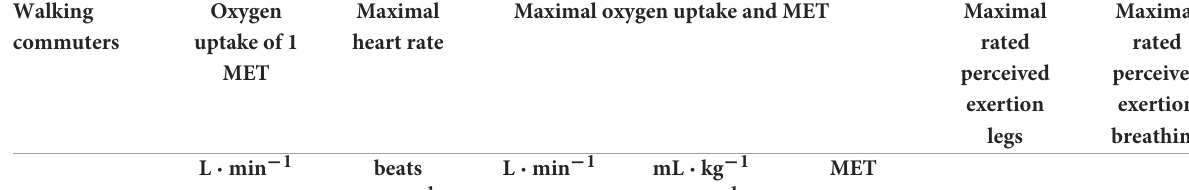
TABLE 3 Maximal values of heart rate, oxygen uptake, MET and rated perceived exertion in maximal ergometer cycling as well as the oxygen uptake of 1 MET (mean, SD and 95% CI). Walking